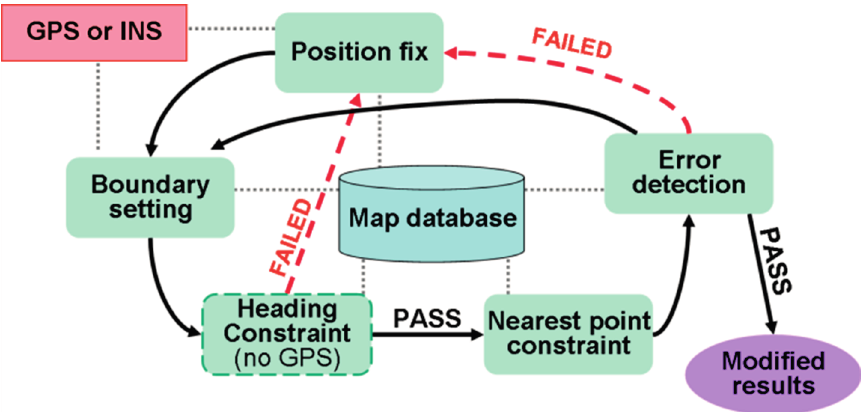
Figure 6. Flowchart of MM